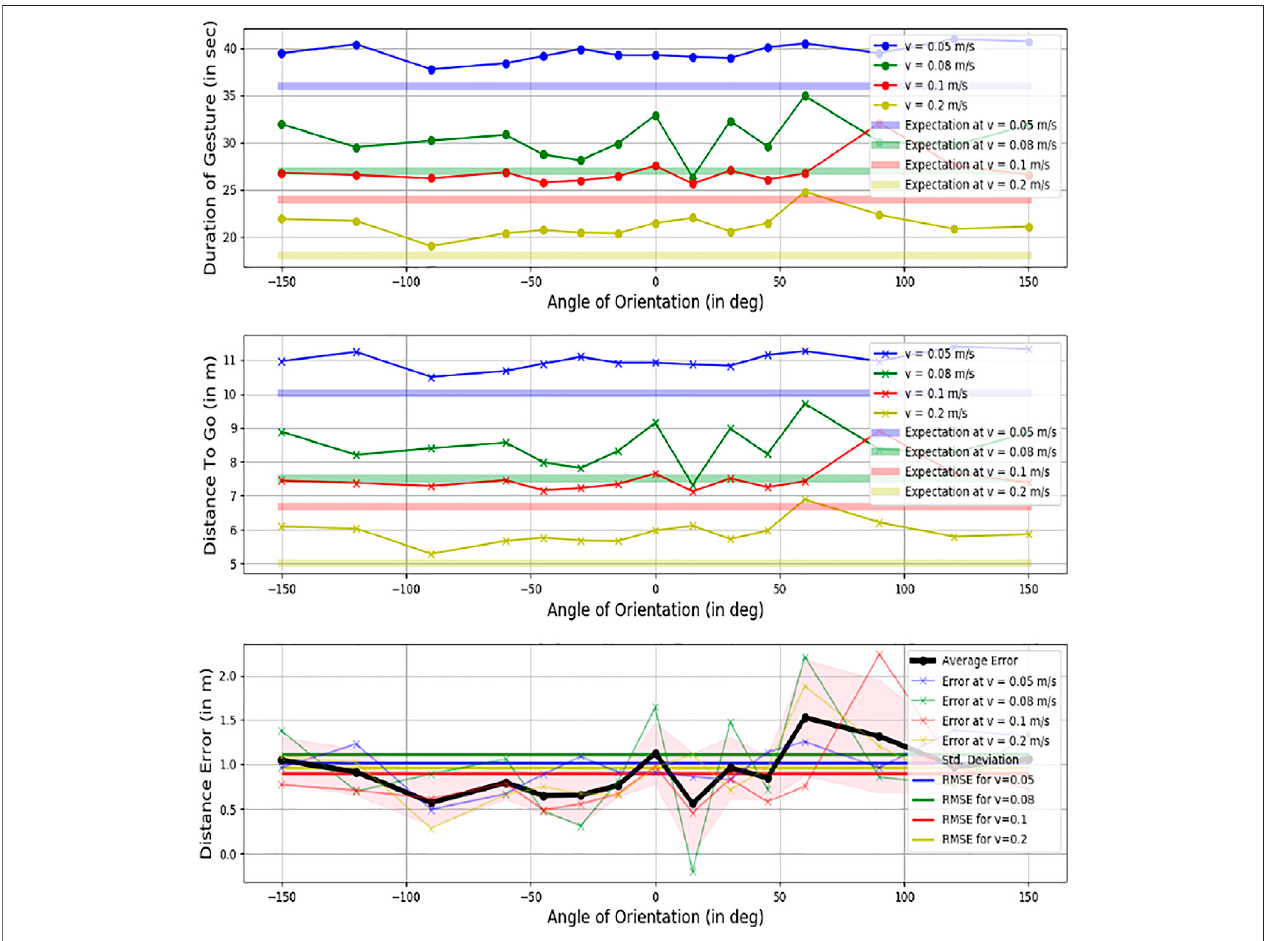
FIGURE 12 | Error plot of distance accuracy.